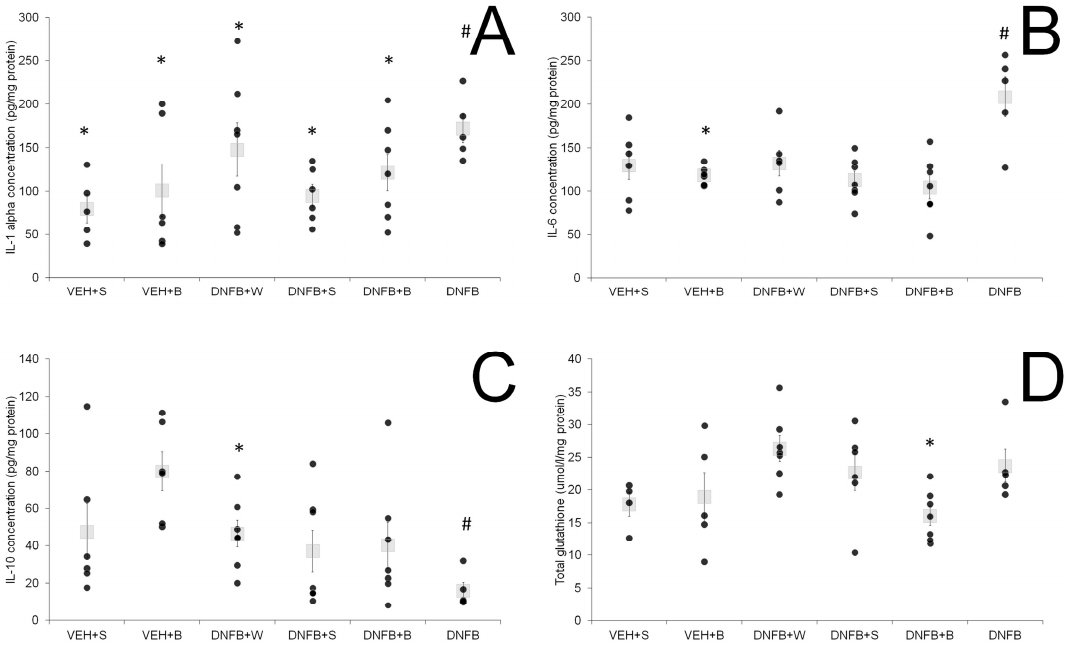
Figure 5. IL-1 α ( A ), IL-1 β ( B ) and IL-6 ( C ) levels in BALF. # p < 0.05 vs. VEH+S (Mann–Whitney U test); * p < 0.05 vs. DNFB (Mann–Whitney U test); means ± SE, n = 5–8; VEH+S, sham-sensitized saline-inhaled; VEH+B, sham-sensitized brine-inhaled; DNFB+W, sensitized pure water inhaled; DNFB+S, sensitized saline inhaled; DNFB+B, sensitized brine inhaled; DNFB, sensitized non-inhaled.